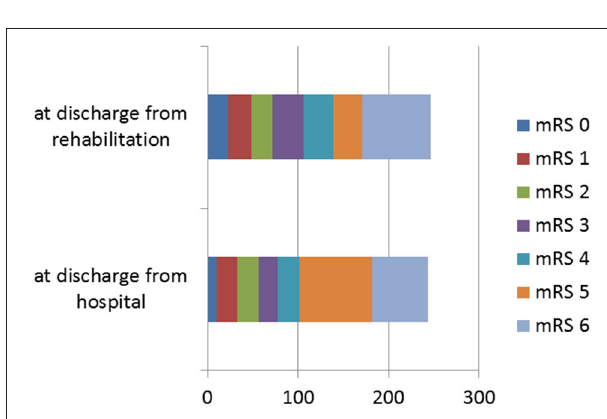
(between 27 and 110), as did their median door-to-groin time (49.5–89.0 min; p < 0.001). The door-to-groin time